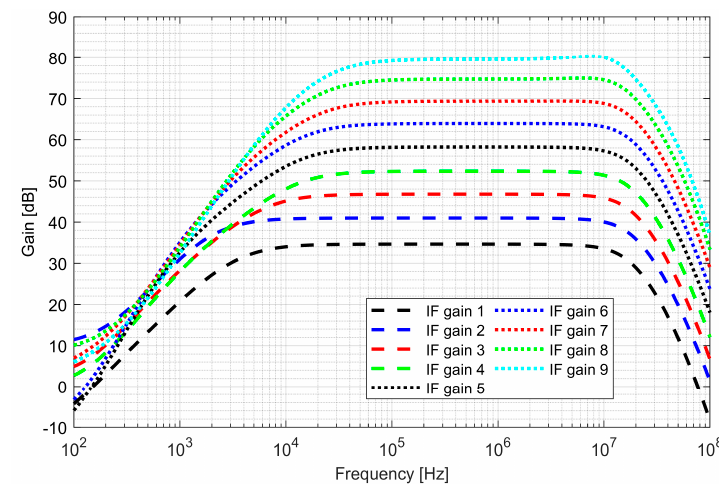
Figure 16. Gain characteristics of the intermediate frequency (IF) chain for different gain settings.